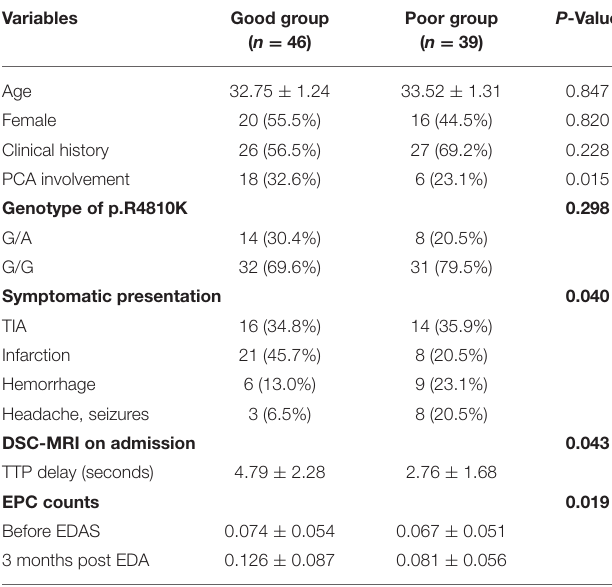
TABLE 3 | The comparison of baseline characteristics between the good post-operative collateral circulation group and the poor group.